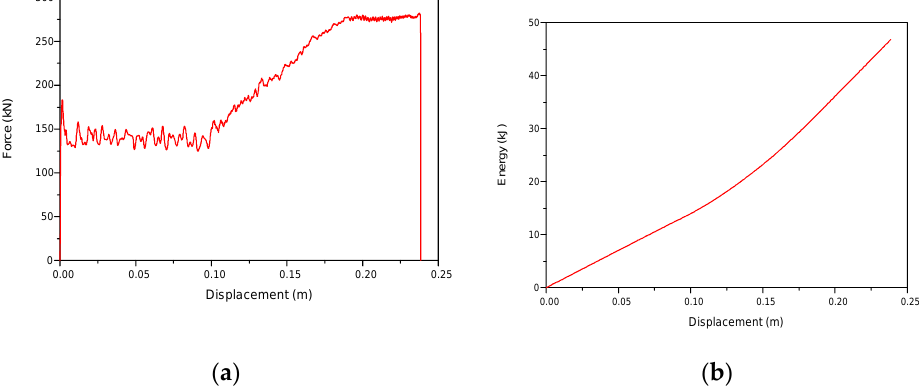
Figure 6. Force-displacement and energy-displacement curves. ( a ) Cushioning force-stroke curve; ( b ) energy-stroke curve.